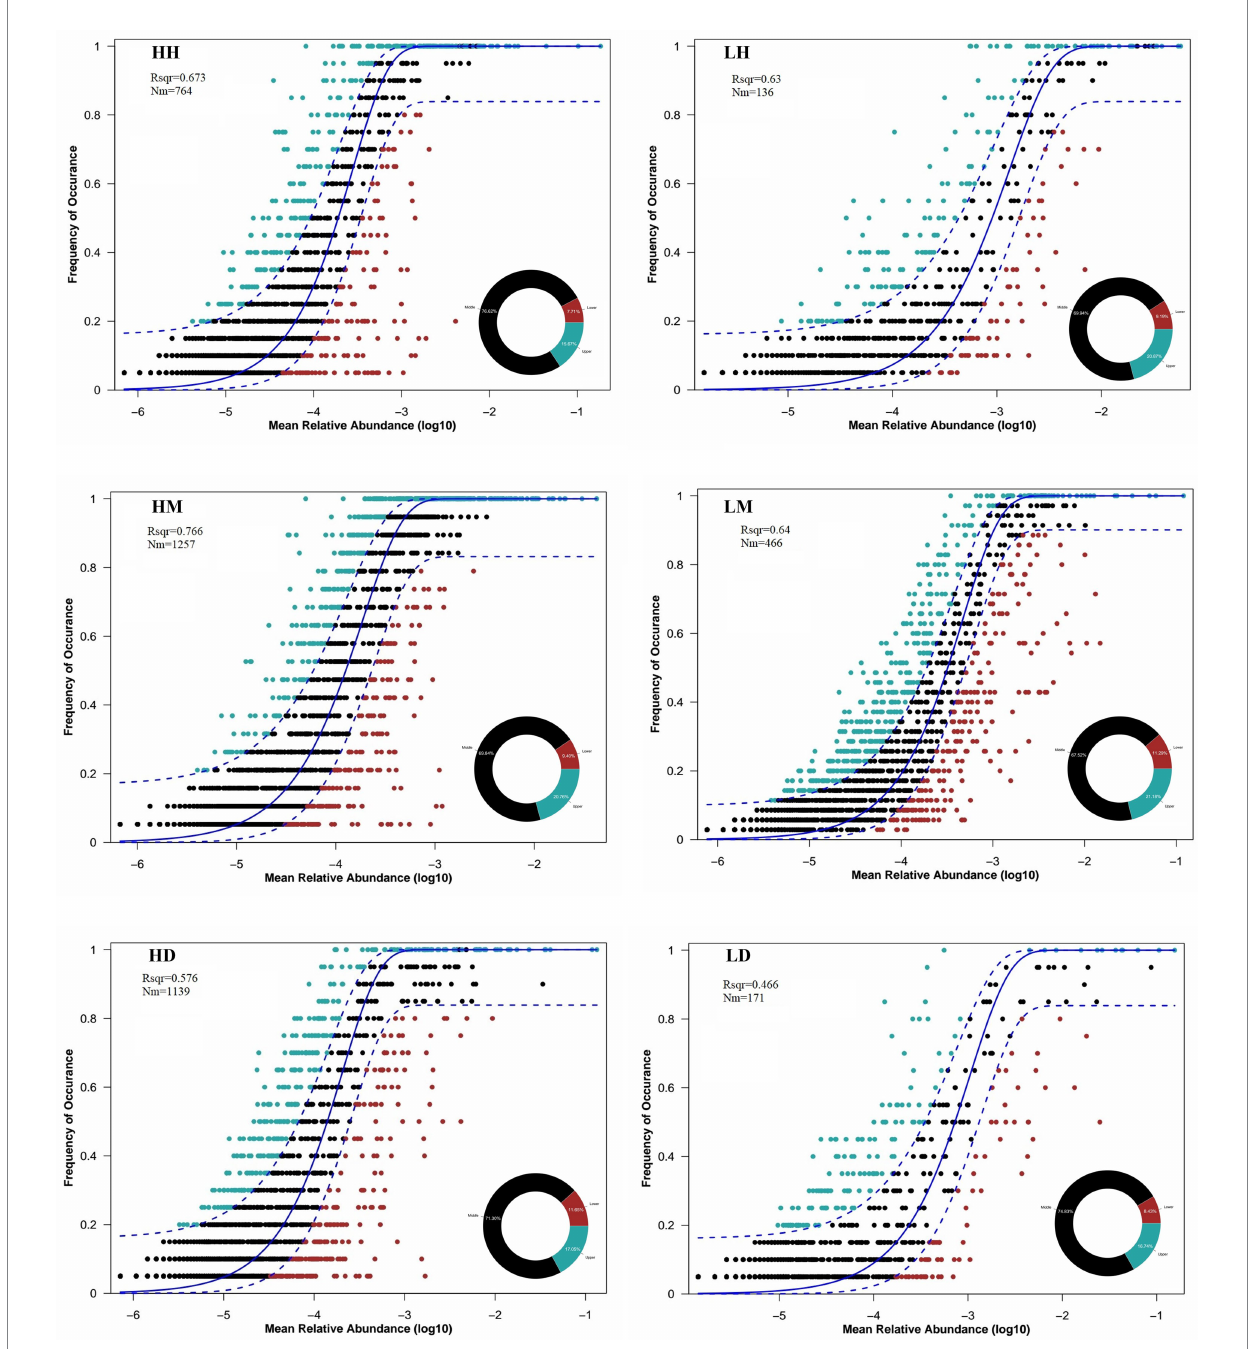
FIGURE 7 Quantitative results of the random process of gut microbiota community assembly in different groupings based on NCM. The solid black line represents the best fit to the NCM, and the dashed black line represents the 95% confidence interval around the model prediction. ASVs that occur more frequently or less frequently than NCM predictions are shown in different colors. “Nm” indicates the diffusion coefficient, and “Rsqr” indicates the fit to the model. HH stands for high altitude humans, HD stands for high altitude dogs, HM stands for high altitude wild macaques, LH stands for low altitude humans, LD stands for low altitude dogs, LM stands for low altitude wild